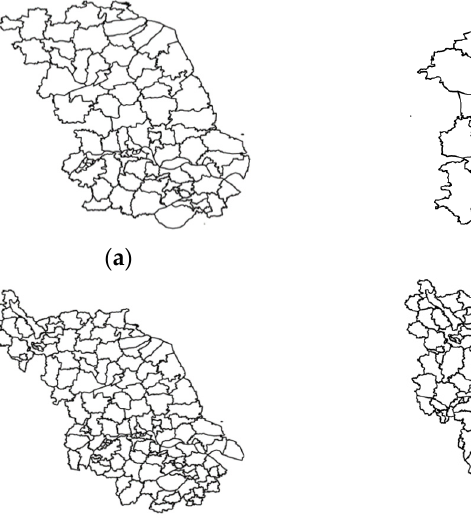
Table 2. Watermark extraction results under translation, scaling, and rotating attacks.